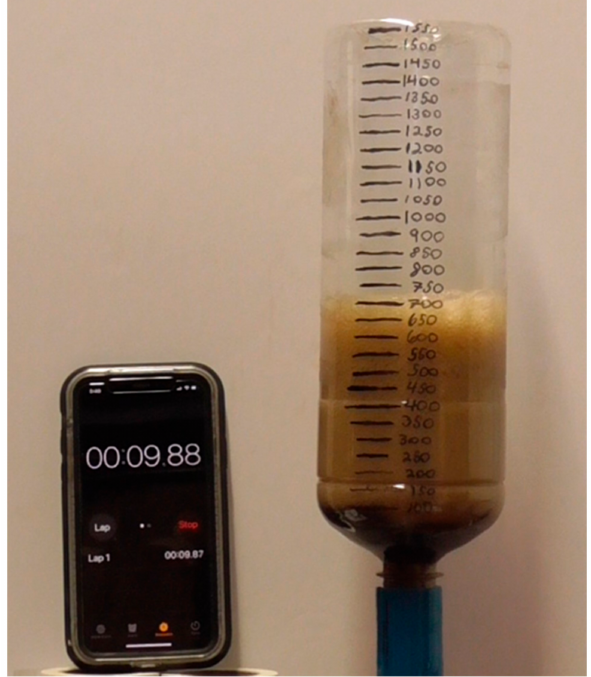
Figure 7. Image of home-built foam collector pictured 4.88 s after dropping a single Mentos candy into a sample prepared from 500 mL of Diet Coke at 20 ◦